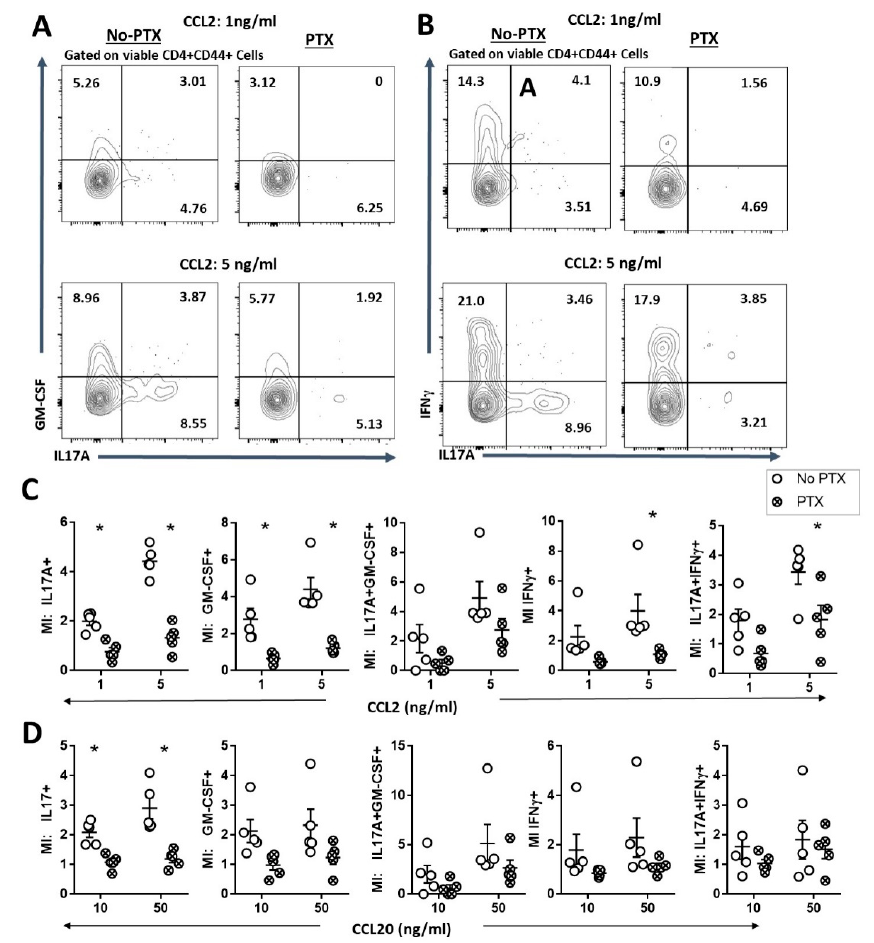
Figure 3. Pertussis toxin inhibited chemotaxis of activated Th17 cells in culture. Trans-well chemotaxis to CCL2 and CCL20 was performed on cells harvested from spleens and lymph nodes of MOG/CFA immunized mice at day 10 and polarized under Th17 conditions with or without PTX (100 ng/ml) for 72 hours. (A) Representative flow cytometry plots of migrated CD4 + CD44 + T cells expressing IL17A and GM-CSF in the lower chamber. (B) Representative flow cytometry plots of migrated CD4 + CD44 + T cells expressing IL17A and IFN γ in the lower chamber. (C) Migration index (MI) to CCL2-dependent chemotaxis of IL17A + , GM-CSF + , IFN γ + , IL17A + GM-CSF + and IL17A + IFN γ + CD4 + CD44 + T cells in the lower chamber. (D) Migration index (MI) to CCL20-dependent chemo- taxis of IL17A + , GM-CSF + , IFN γ + , IL17A + GM-CSF + and IL17A + IFN γ + CD4 + CD44 + T cells in the lower chamber. Mi- gration index was calculated by normalizing the absolute number of cells to the no-chemokine control; n = 5/group. Statistical analysis was performed using Student’s t -test (* p < 0.05).